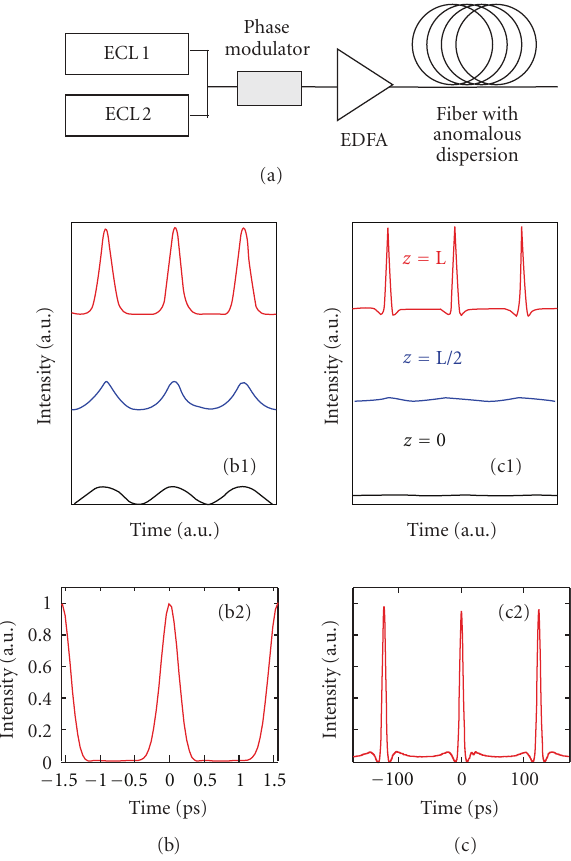
Figure 1: (a) Experimental setup for high repetition rate pulse train generation. (b, c) Results obtained for the optimum output shape and for the best compression, respectively. The temporal intensity profiles at di ff erent stages as predicted by numerical simulations (subplots 1) are compared to the experimental results (subplots 2) obtained by the FROG technique (b2—results adapted from [25]) or by an optical sampling oscilloscope (c2—results adapted from